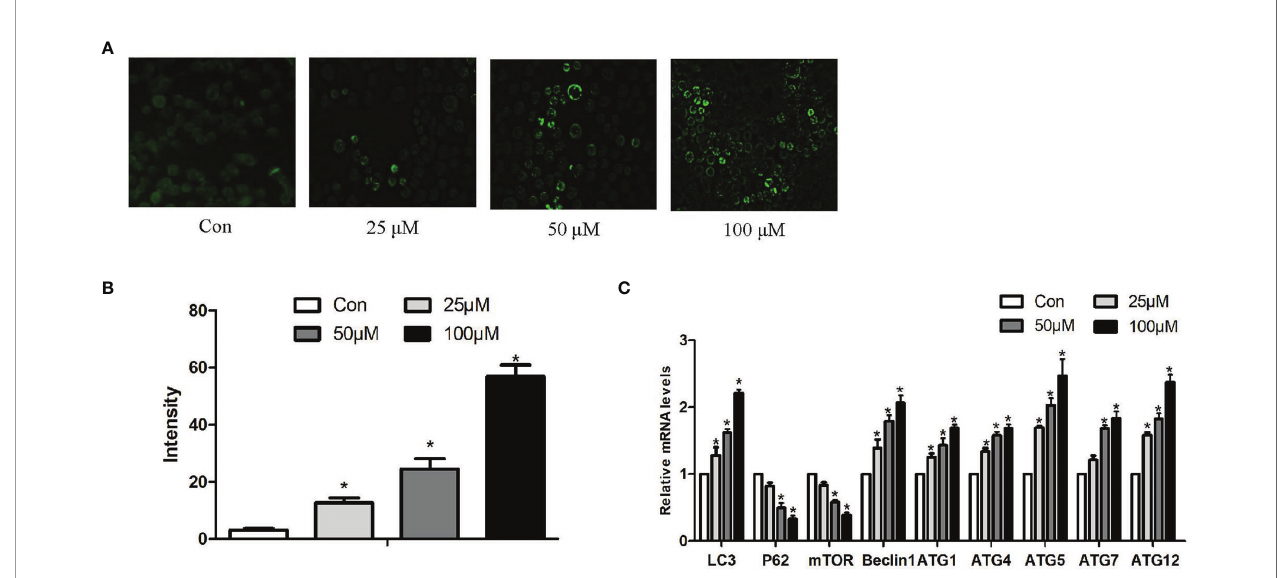
FIGURE 3 | Effects of Sch B on autophagy in Hepa1-6 cells. (A) MDC staining was performed in Hepa1-6 cells with Sch B treatment at 0-, 25-, 50-, and 100- m M concentrations. Hepa1-6 cells were visualized using fl uorescence microscopy. (B) The quantitative analysis of MDC staining. (C) Autophagy-related gene mRNA levels in Hepa1-6 cells with 0-, 25-, 50-, and 100- m M Sch B treatment. ∗ shows a signi fi cant difference from the corresponding control ( P < 0.05). n =